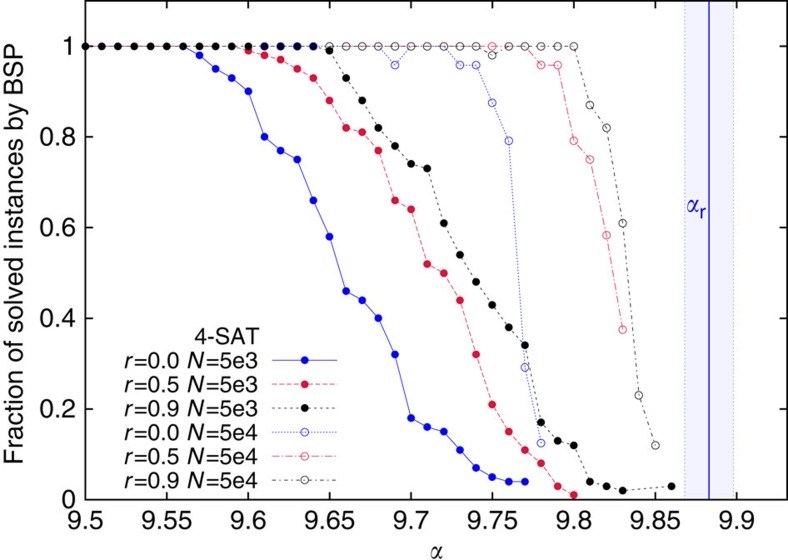
Fraction of random 4-SAT instances solved by BSP as a function of the constraints per variable ratio α.The average is computed over 100 instances with N=5,000 (solid symbols) and N=50,000 (empty symbols) variables. The vertical line is the best estimate for αr and the shaded region is the statistical error on this estimate. For each instance, the algorithm has been run once; on instances not solved on the first run, a second run rarely (<1%) finds a solution. The plot shows that the backtracking (r>0) definitely makes the BSP algorithm more efficient in finding solutions. Although data become sharper by increasing the problem size N, a good estimation of the algorithmic threshold from these data sets is unfeasible.